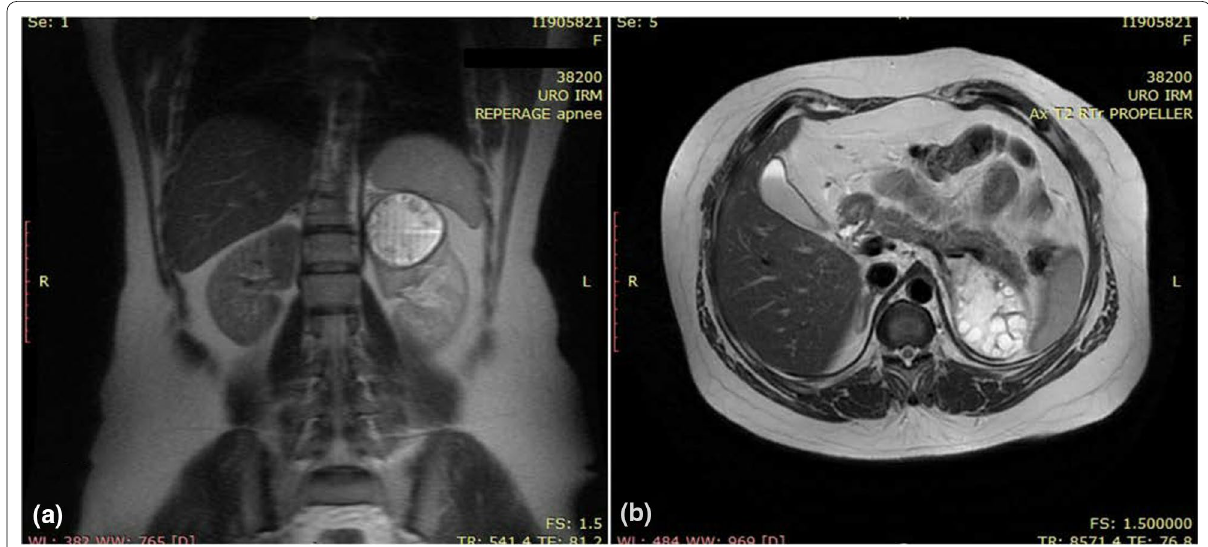
Fig. 1 MRI findings: a left renal mass with cystic and solid components, showing discreet enhancement classified as Bosniak-IV